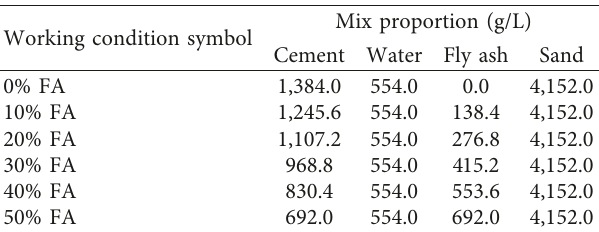
Table 2: Design of mix proportion.